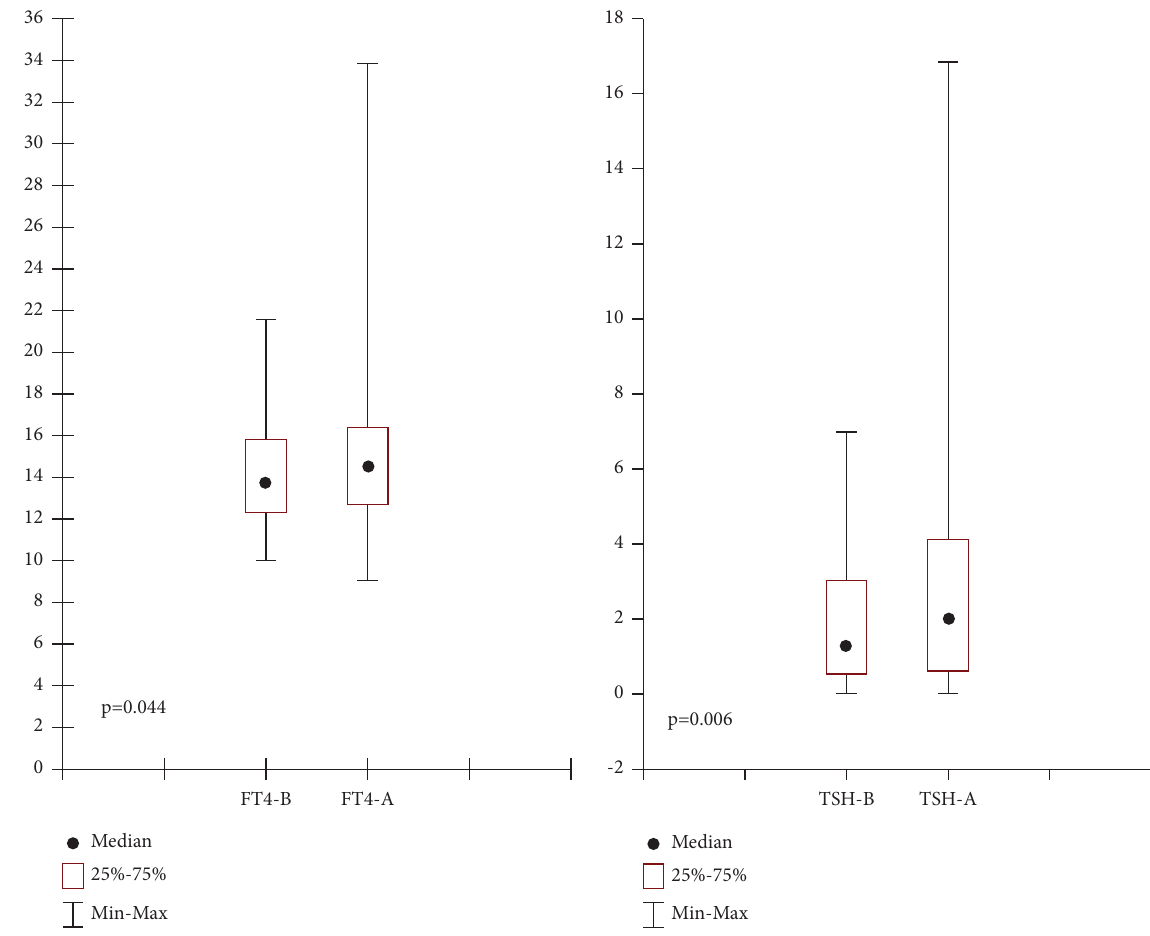
Figure 2: Wilcoxon pairwise test for overall FT4 and TSH values before (B) and after (A)